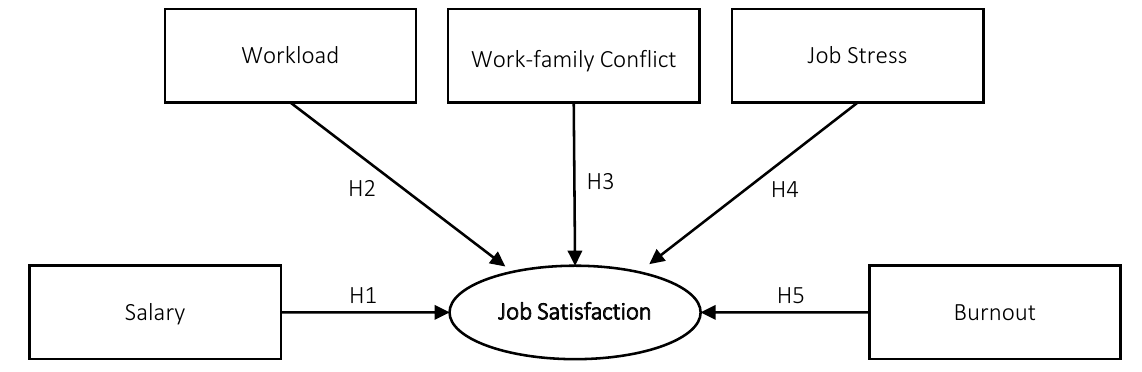
Figure 1. Research